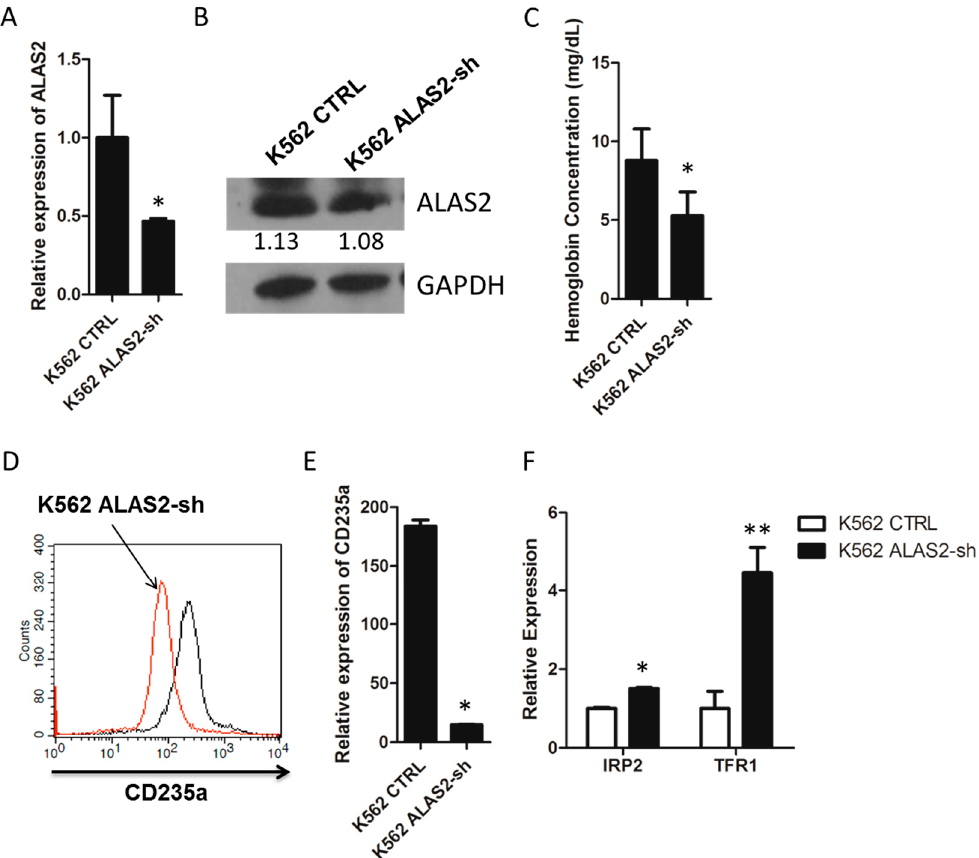
Figure 1. ( A ) Relative mRNA expression of ALAS2 in K562 control and K562 ALAS2-sh cells using quantitative real-time PCR; ( B ) Representative Western blots showing ALAS2 expression in K562 control and K562 ALAS2-sh cells. Quantification normalized to GAPDH by densitometry using ImageJ was provided; ( C ) Hemoglobin concentration of K562 control and K562 ALAS2-sh cells. Cell surface expression of CD235a ( D ) and mRNA levels ( E ) of K562 control (black line in D ) and K562 ALAS2-sh using FACS and quantitative real-time PCR, respectively; ( F ) Relative mRNA expression of IRP2 and TFR1 in K562 control and K562 ALAS2-sh cells using quantitative real-time PCR. All relative mRNA expression using quantitative real-time PCR was normalized to glyceraldehyde-3-phosphate dehydrogenase ( GAPDH ) expression. Asterisks indicate that differences between samples were statistically significant according to an independent-sample t -test, * p < 0.05, ** p < 0.01.